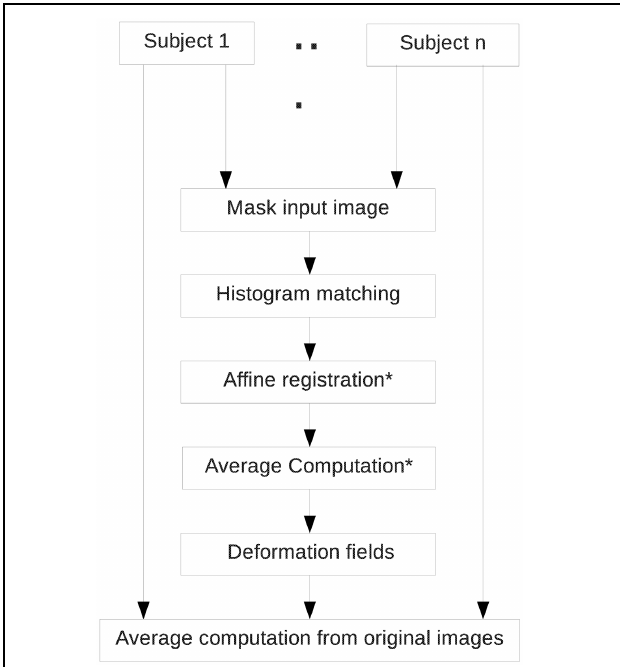
FIGURE 5 | Population average computation pipeline. Registration is performed using RegisterImages (distributed with 3D Slicer) and Average Computation is done with